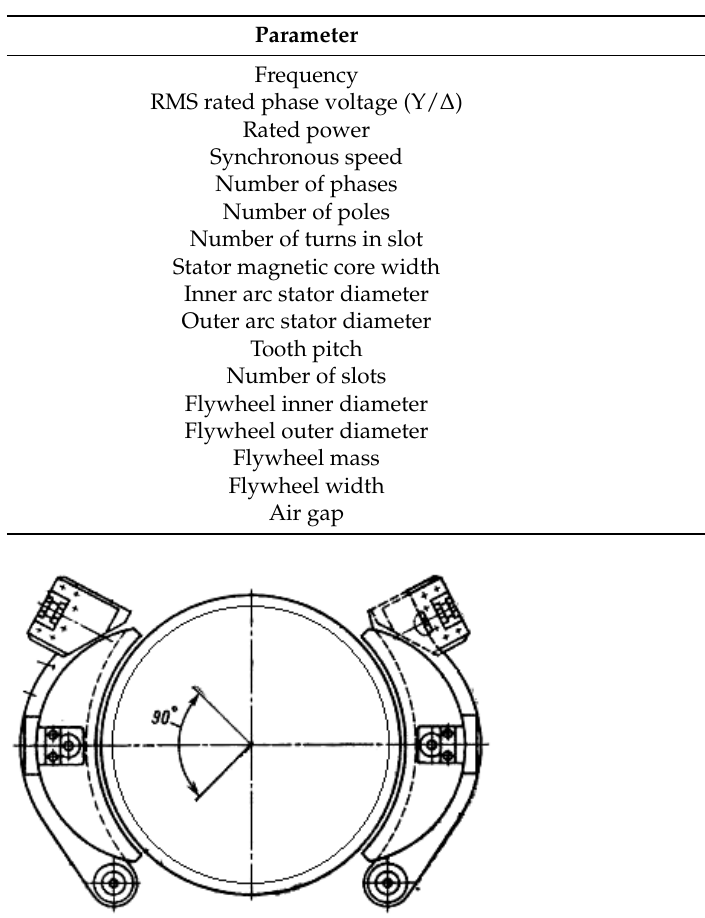
Figure 13. Arc stators of the screw press arc IM before mounting. Table 8. Parameters of the screw press arc IM.